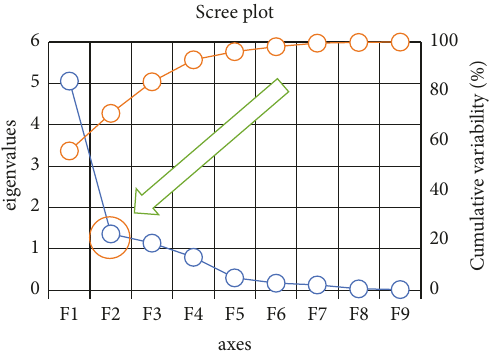
Figure 5: Observation of the middle elbow.